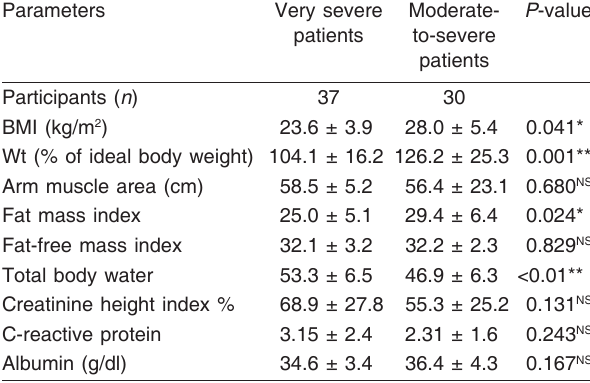
Table 4 Anthropometric parameters in the chronic obstructive pulmonary disease group as regards severity of airflow limitation based on forced expiratory volume in the first second